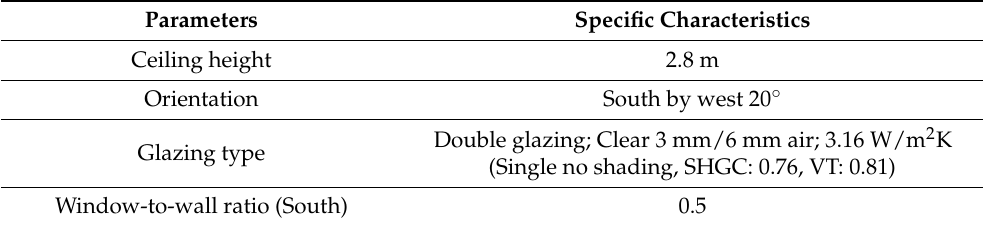
Table 6. Specific characteristics of the construction changes in the passive design rural house.